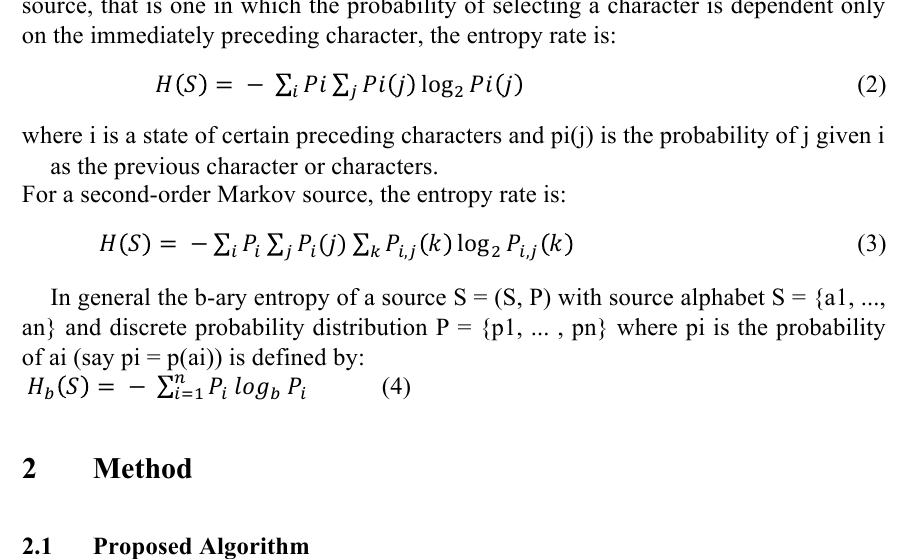
Short Paper— A Text Steganographic System Based on Word Length Entropy